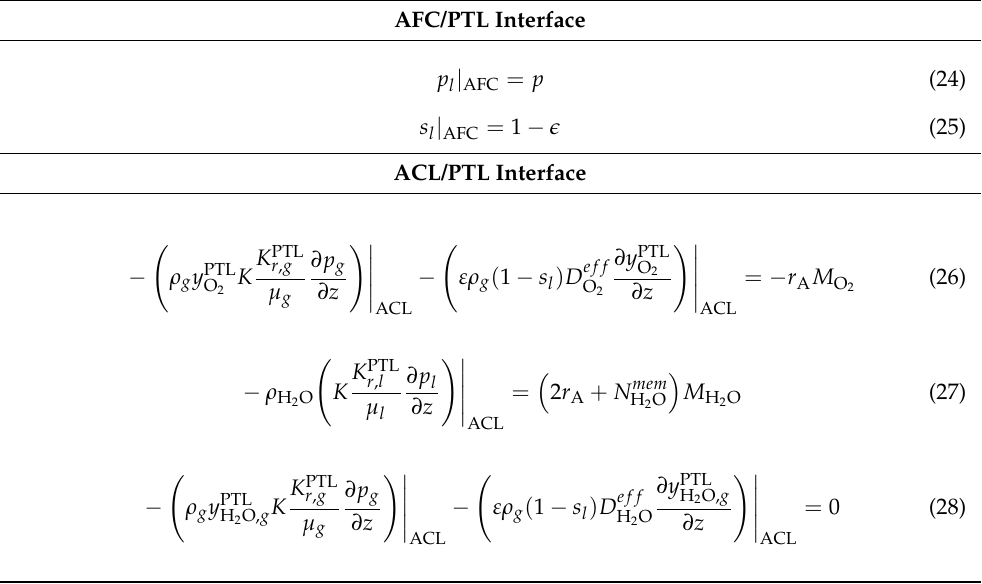
Table 1. Boundary conditions for partial differential equations of the PTL